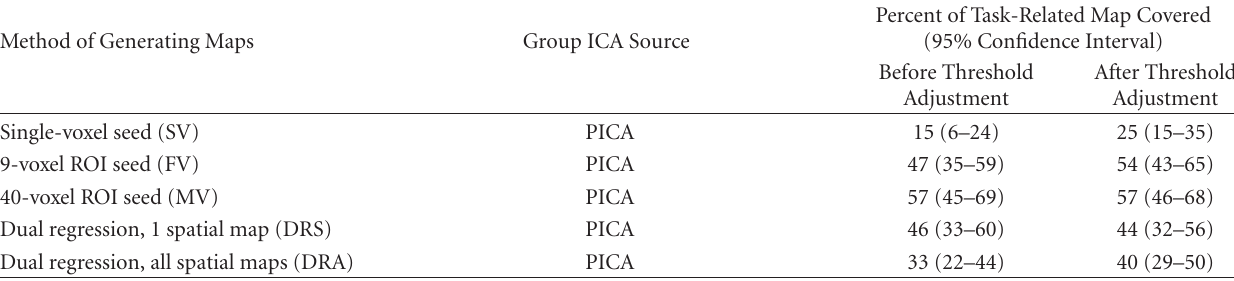
Table 6: Experiment 4: mean percentages of thresholded task-related GLM maps that are covered by the thresholded subject-specific FC maps generated with each hybrid method below. The right-most column gives percentages after adjusting the z-score used to threshold the FC maps so that number of false positives equals number of false negatives. In contrast with Experiment 3, the results for the SV method were significantly lower than those for the FV, MV, and DRS methods. The di ff erence between Experiments 3 and 4 was that Experiment 4 was based on a group ICA that produced 5 components rather than 14. As explained in the text, the di ff erences in results between these two experiments can be accounted for by subtle di ff erences between the seed-source ICs, which led to markedly di ff erent brain locations for the single-voxel